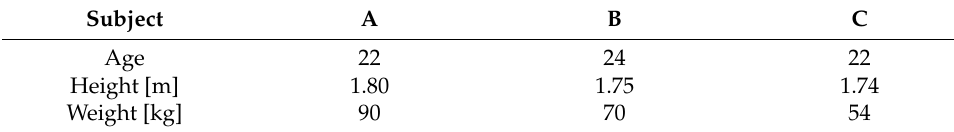
Table 3. Subject information in the assist evaluation of the standing-up